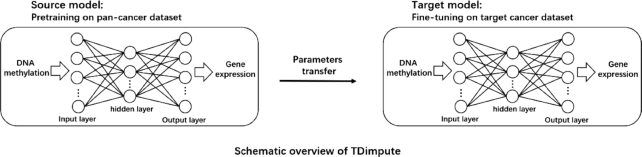
The architecture of a transfer learning–based neural network (TDimpute) for imputing missing gene expression values in a multi-omics dataset. The neural network: DNA methylation data are transformed into gene expression data and the root mean squared error (RMSE) between the actual output and desired output is minimized. Transfer learning: a pan-cancer dataset is used to train the general imputation model for multiple cancers, which is specifically tuned for each type of cancer.